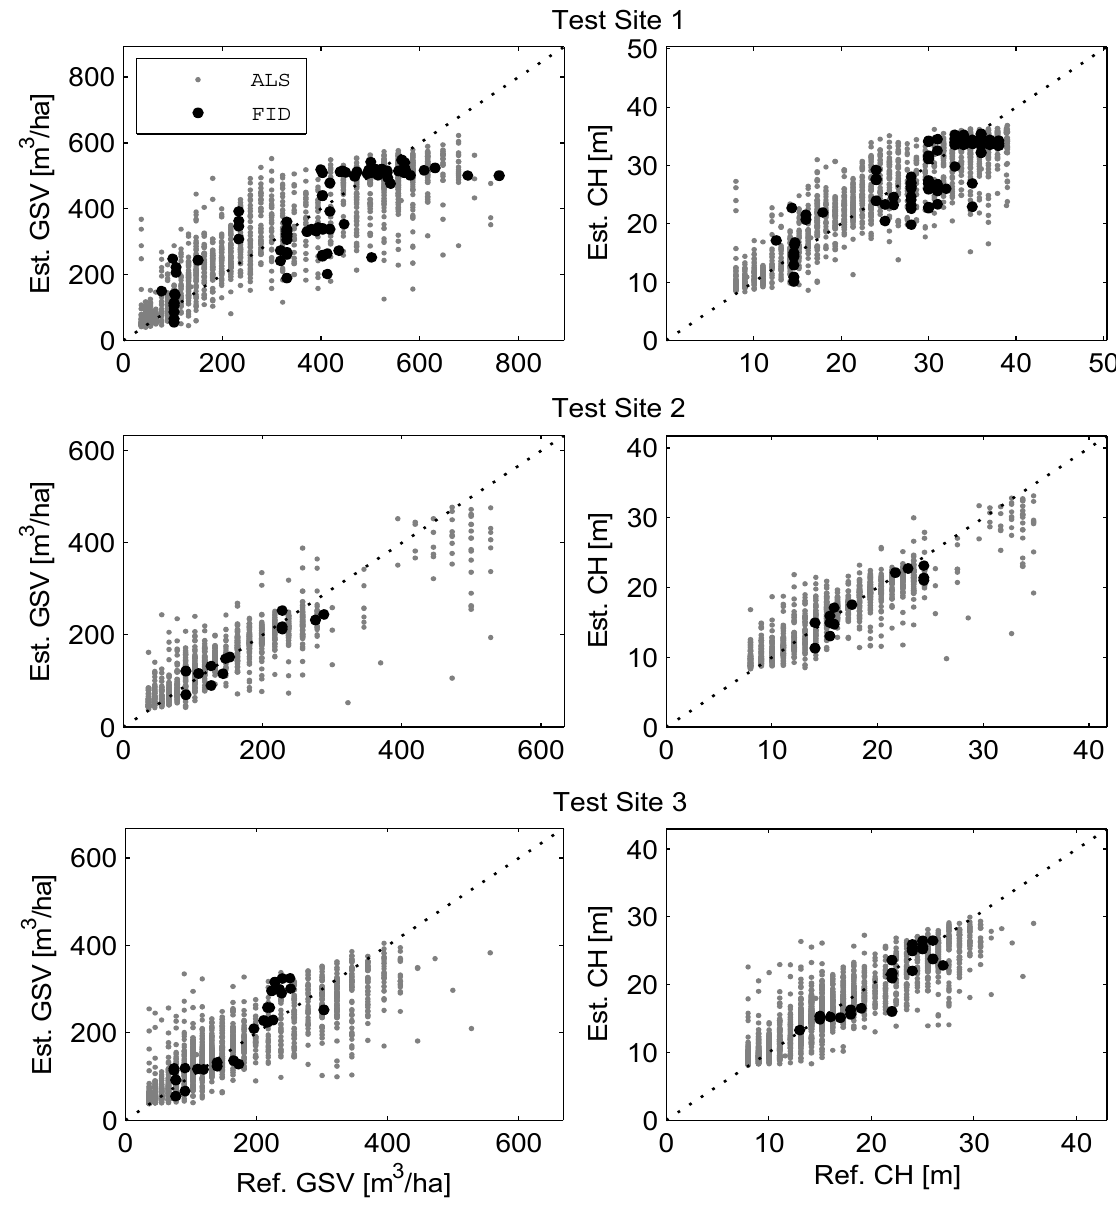
Figure 6. Estimates of GSV and CH obtained through fusion of multi-temporal dual-polarization ALOS PALSAR intensities and coherence and Landsat ETM+ data versus (1) Lidar estimates of GSV and CH for segments derived from the CHM (grey dots) and (2) in situ measurements of CH and GSV (black